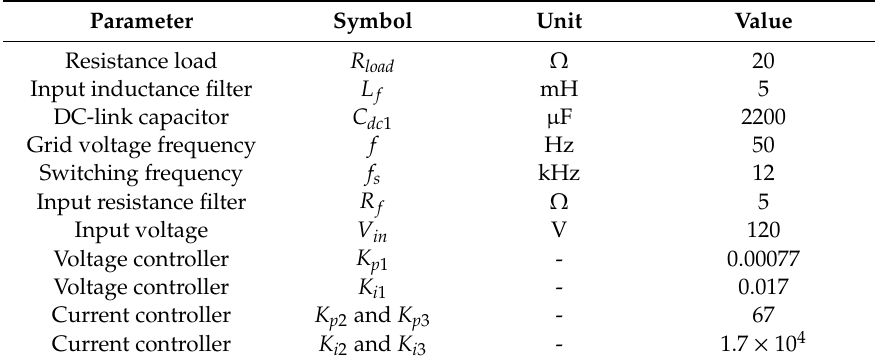
Table 1. Parameter specifications for Level 1